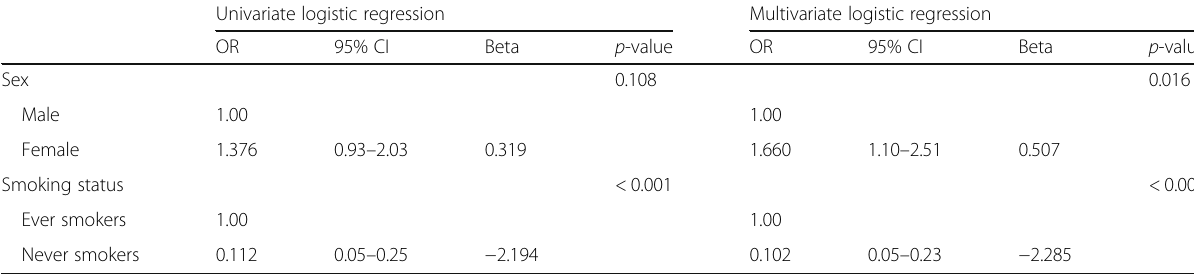
Table 7 Logistic regression analysis of KRAS mutational status Univariate logistic regression Multivariate logistic